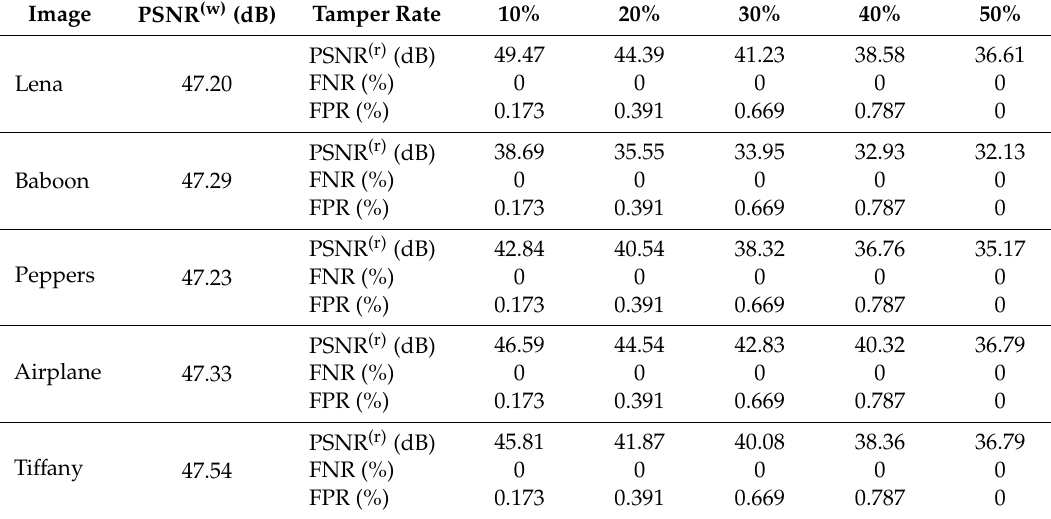
Table 3. Comparison of the 4 × 4 “block-wise detection”.